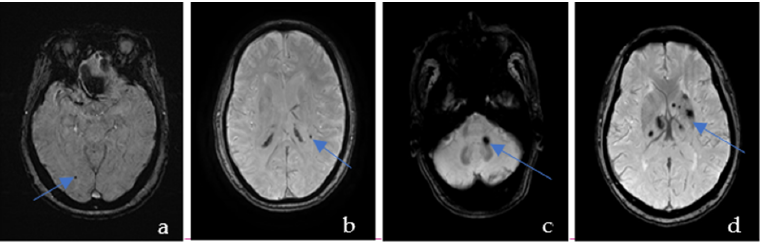
Figure 1. Susceptibility ‐ weighted imaging showing an example of the cerebral microbleeds in the lobar ( a ), deep ( b ), infratentorial ( c ), and mixed regions ( d